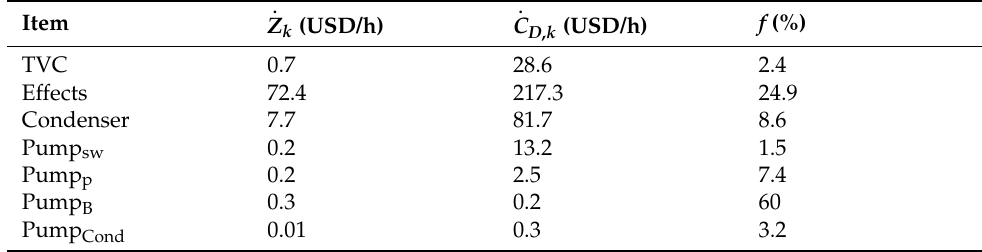
Table 5. Exergoeconomic analysis